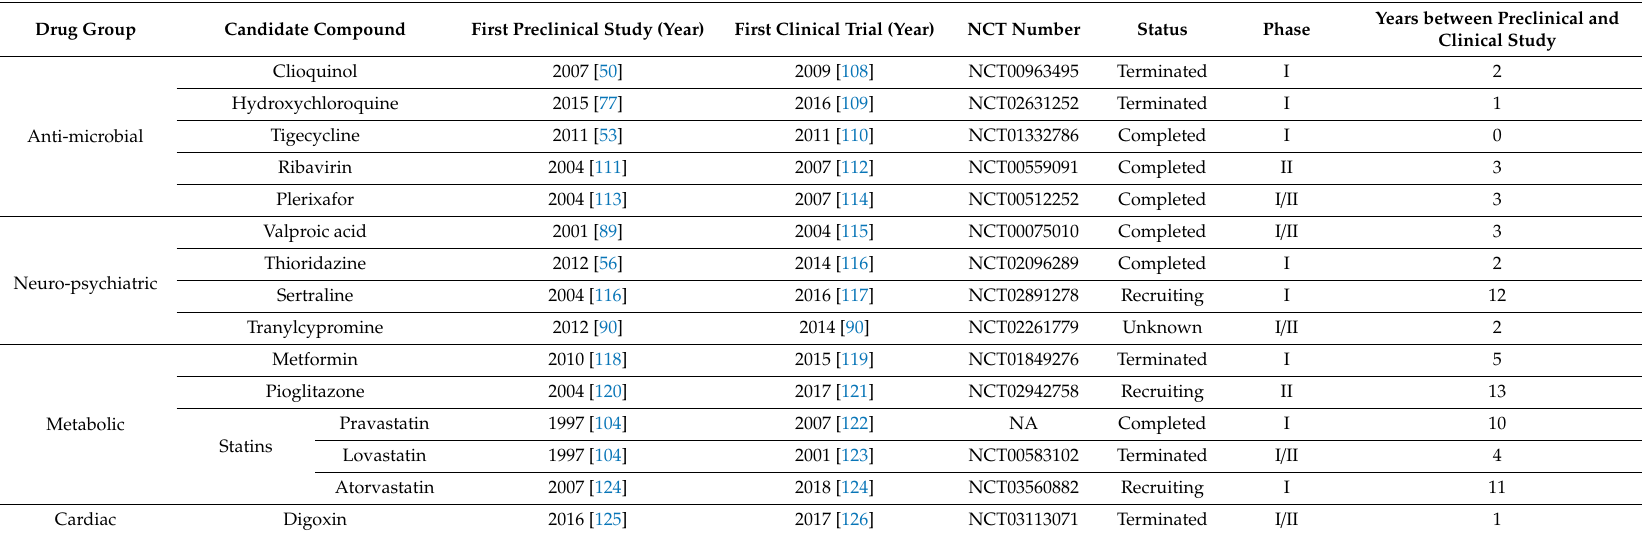
Table 2. Starting year of first clinical trials for repurposed